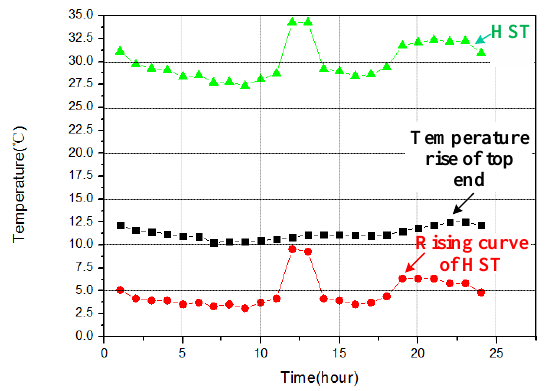
Figure 7. The temperature rise curve on 1 January, 2013.